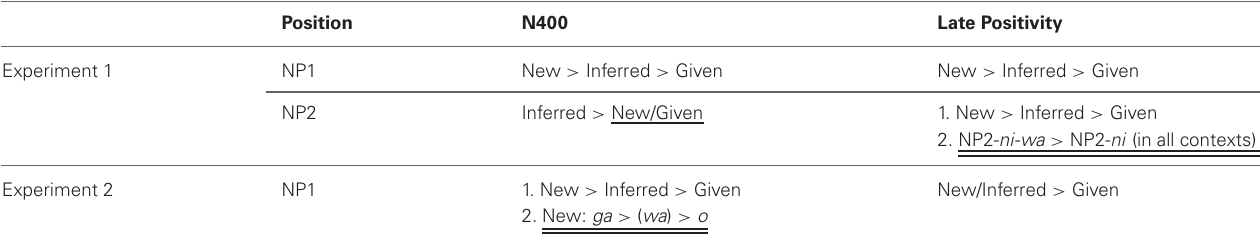
Table 5 | ERP components and patterns at the critical